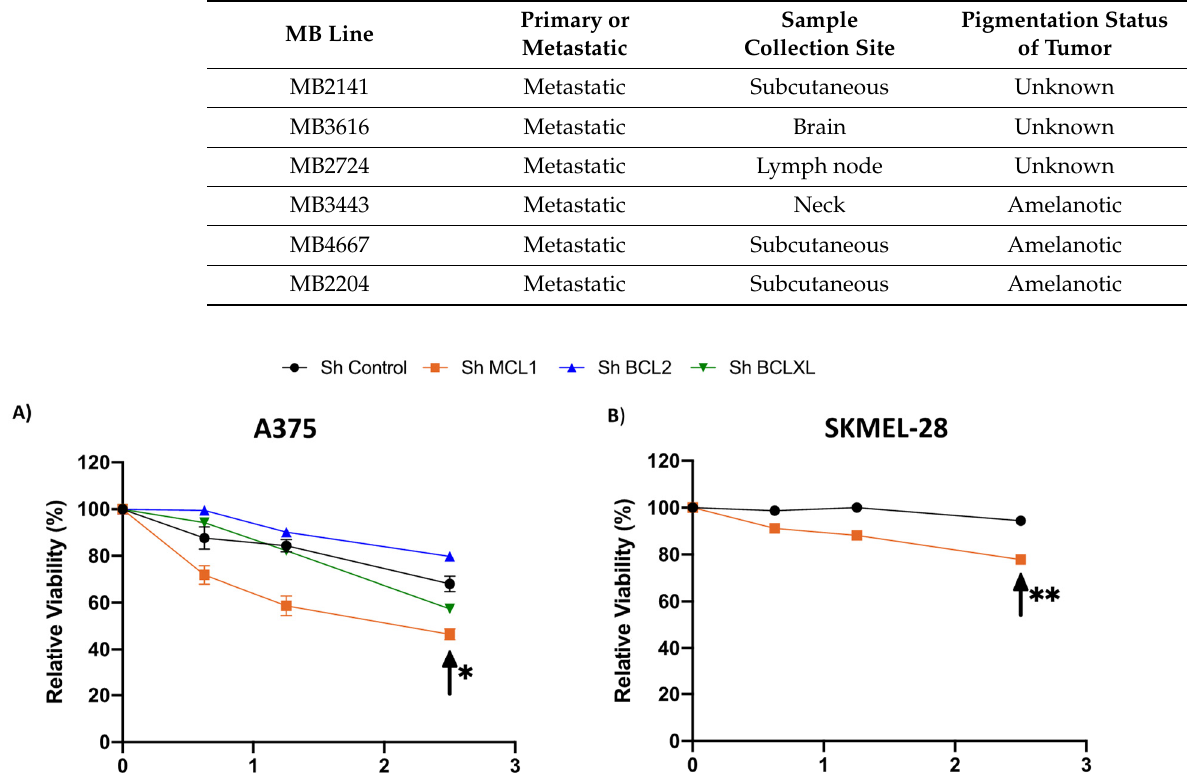
Table 2. Details of patient derived cell lines used.